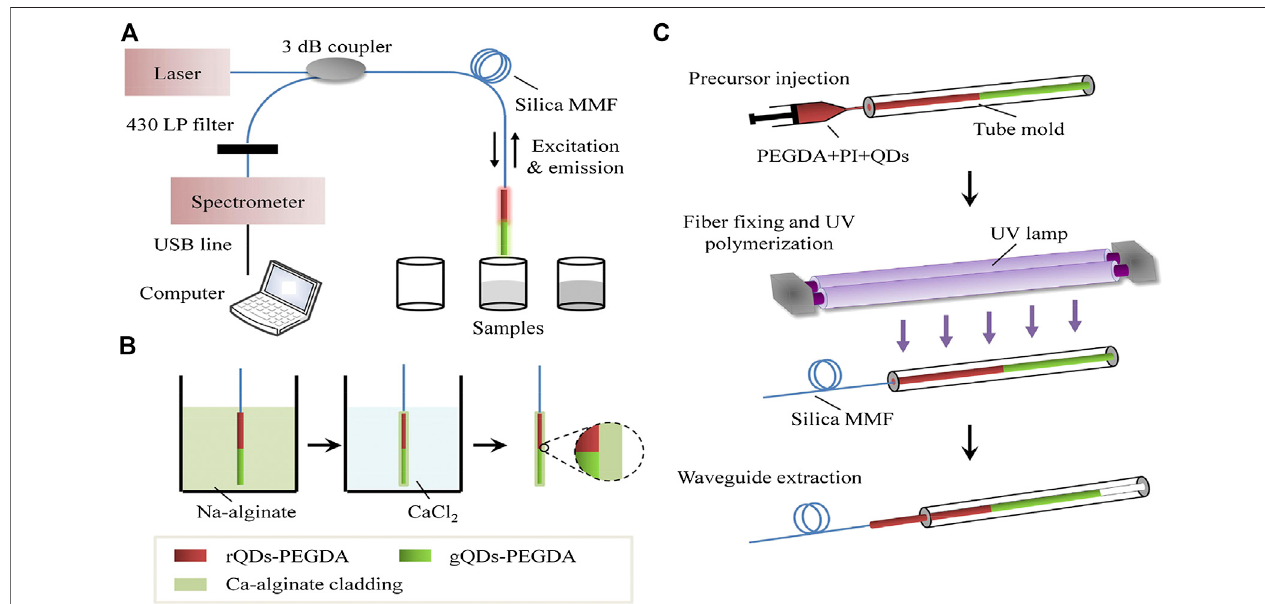
FIGURE 1 | Optical setup for sensing of Fe 3+ ions based on the ratiometric fi ber sensor ( A ); Cladding encapsulation ( B ); Fabrication steps of the fi ber core doped with QDs ( C ). [24].